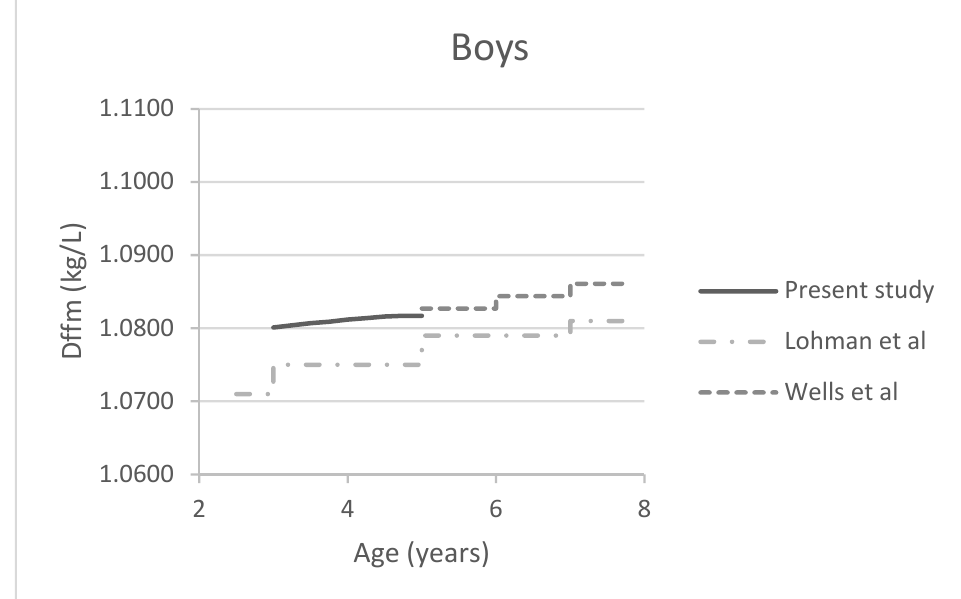
Figure 2. Dffm estimates plotted against age for boys and girls separately: Presented are the revised Dffm estimates from present study and those of Lohman et al. and Wells et al. [16]. Abbreviation: Dffm= fat-free mass density. Table 3. Revised fat-free mass density models for children aged 3–5 years.